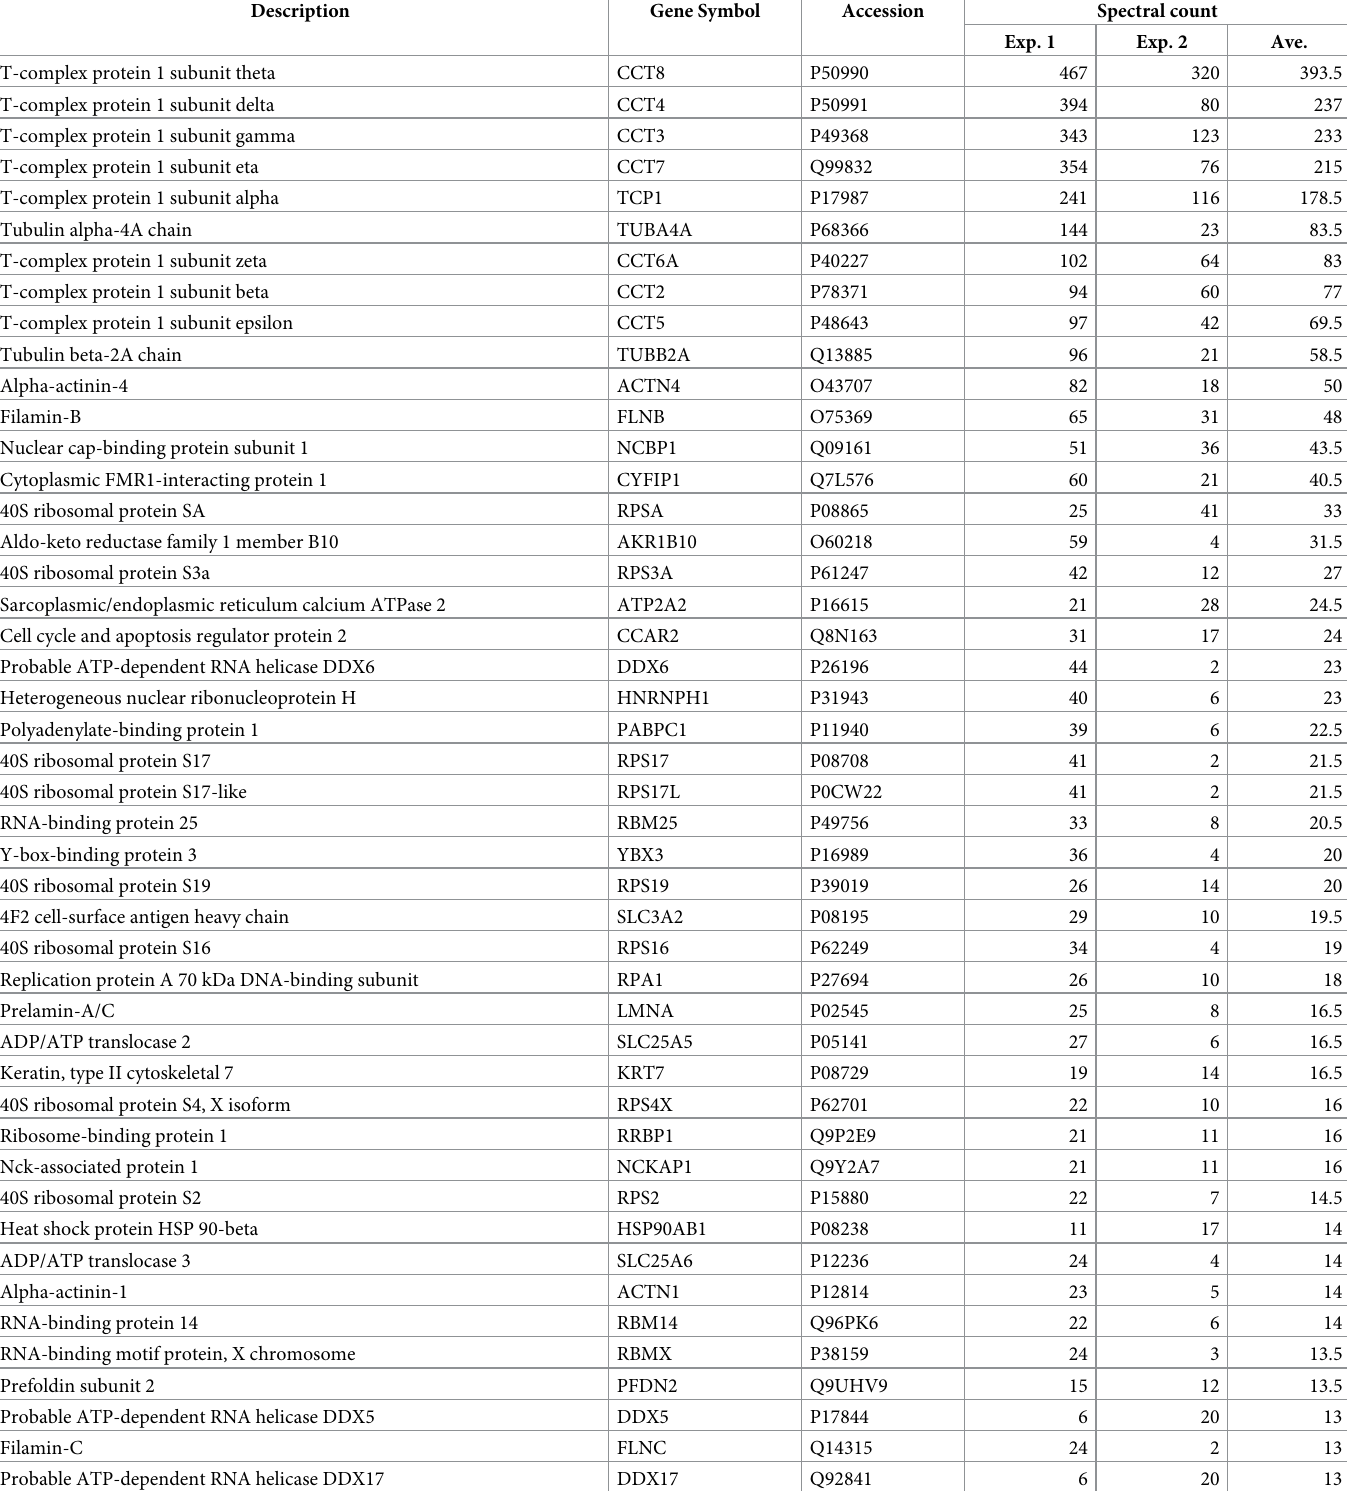
Table 1. List of identified host-cell proteins found only in NP-strep pull down samples with at least five spectral